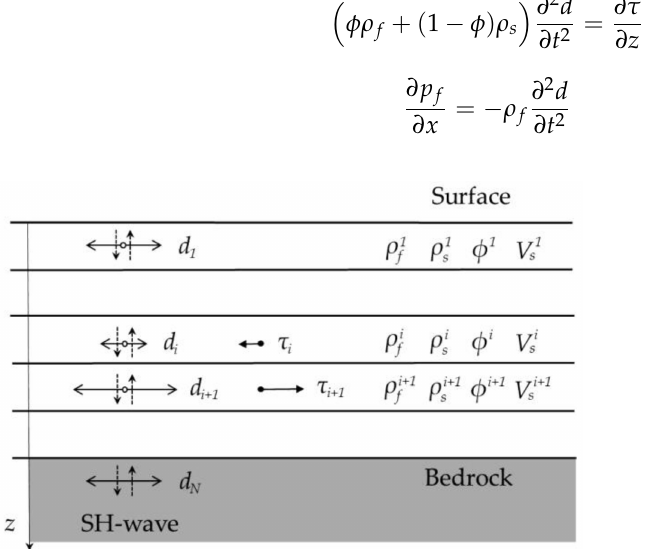
Figure 1. One-dimensional layered soil deposit system and its spatial discretization. IM-model implemented in the NERA code is based on simulating nonlinear hysteretic stress–strain curves using a series of mechanical elements that have different stiffness and sliding resistance. Furthermore, IM-model assumes the Masing rule [34] implementation. The central difference method is used for solving a governing equation of motion.